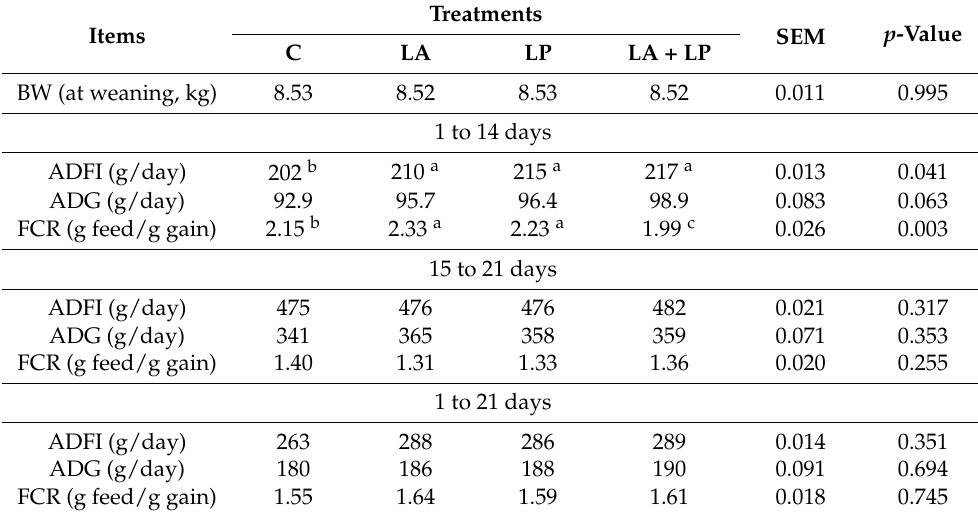
Table 2. Effects of dietary microencapsulated probiotics supplements on growth performance of weaning